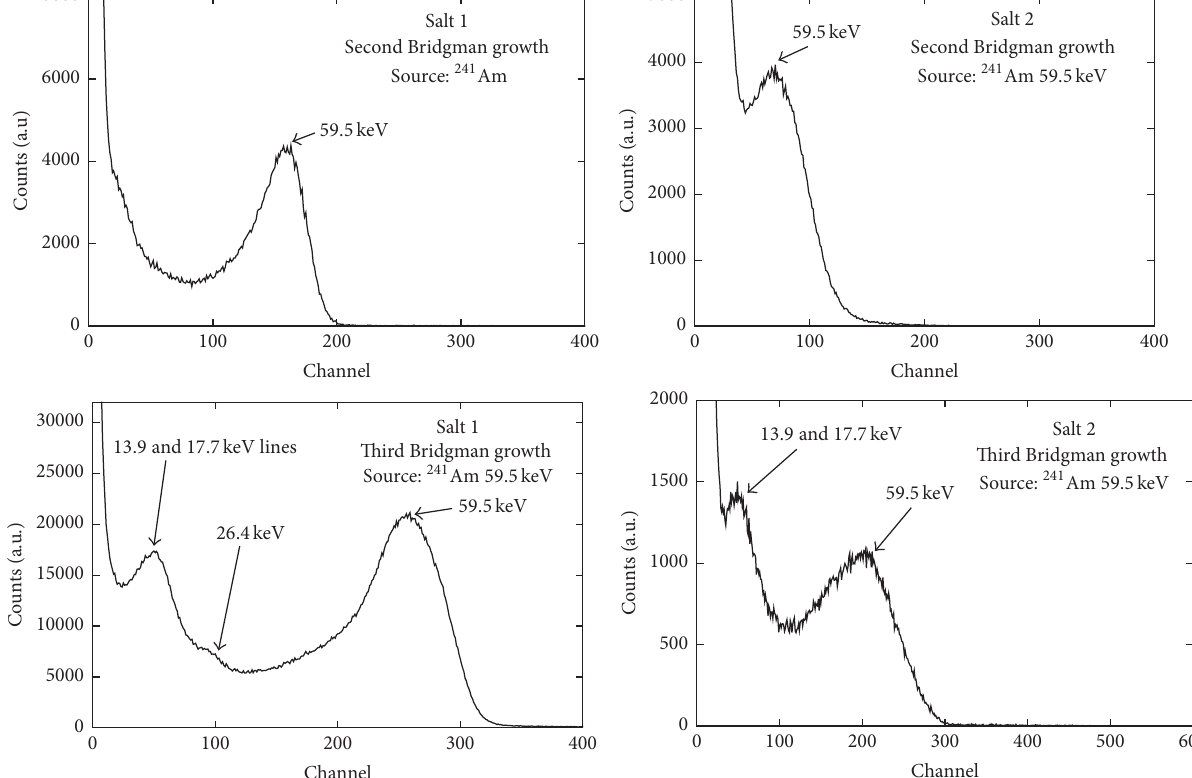
Figure 6: TlBr detector energy spectra under 241 Am excitations. Detectors were prepared using TlBr samples from the middle region of the crystals grown twice and three